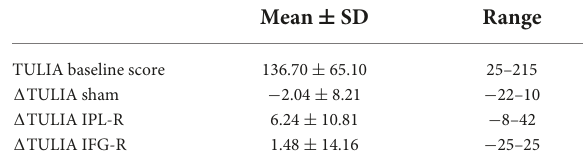
TABLE 2 (cid:49) TULIA values.